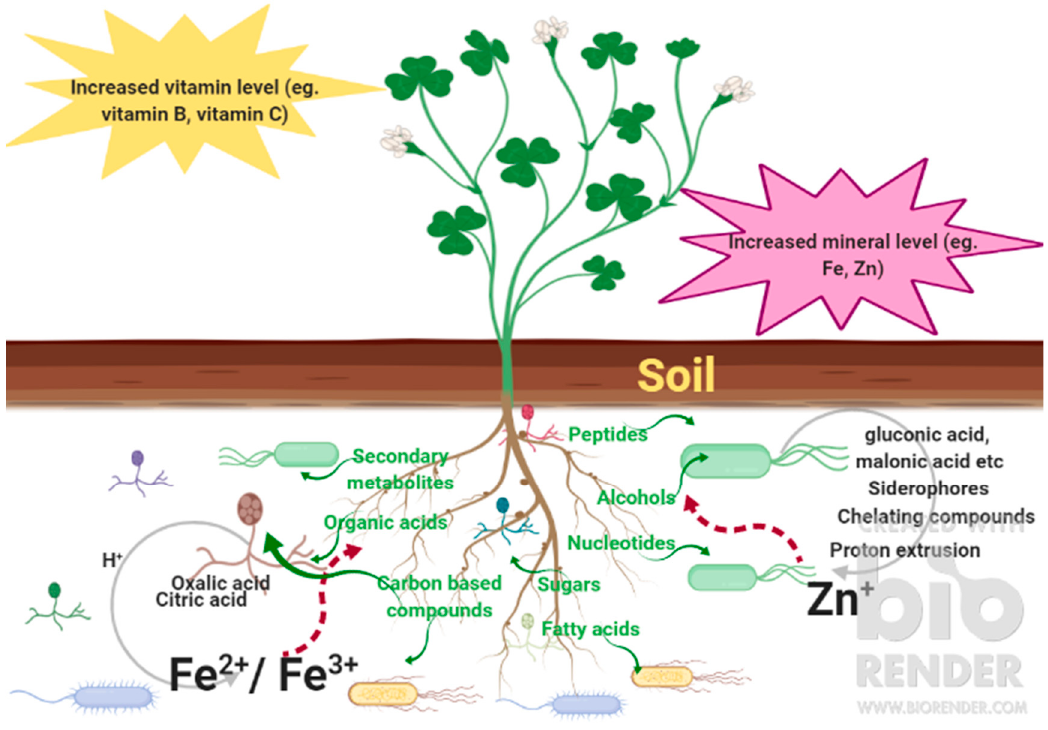
Figure 1. The complex interactions between plants and microbes in the soil bring about microbe- mediated biofortification. This figure is generated by